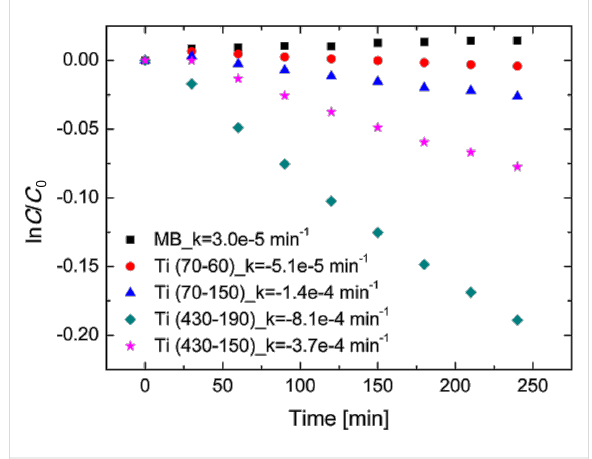
Figure 3: MB degradation under UV light irradiation for five samples: MB (black squares), MB with Ti (70-60) (red circles), MB with Ti (70- 150) (blue triangles), MB with Ti (430-150) (pink stars), MB with Ti (430-190) (green diamonds).